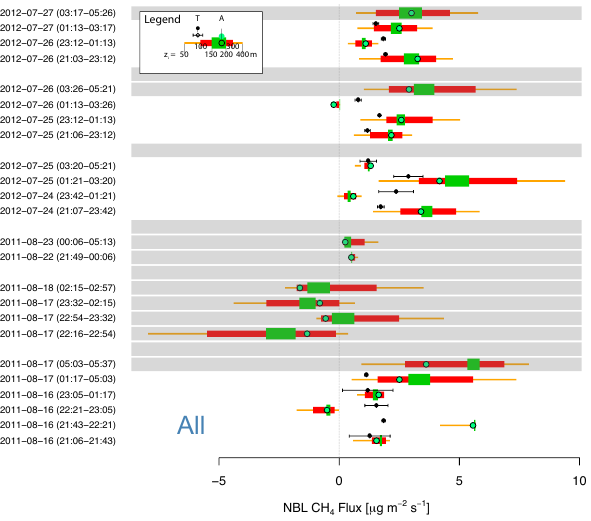
Figure 5. Sensitivity of NBL budget flux calculations on z i used as the upper boundary of integration in Eq. (1) using data from all soundings (one ascent and one descent taken as one sounding). The colour bars show the range of fluxes resulting if z i is uncertain be- tween 50 and 400m (thin orange line), between 100 and 300m (red medium line), or between 150 and 200m (bold green line) using in- terpolated data (see Sect. 2.5). The circles (A) show the NBL budget flux that was achieved when no extrapolation was done beyond the height range that was actually measured, and the black disks and error bars (T) show the values presented in Table 1 following the method described in Sect. 2.3. Soundings with a grey background were considered nonstationary and were not used in this